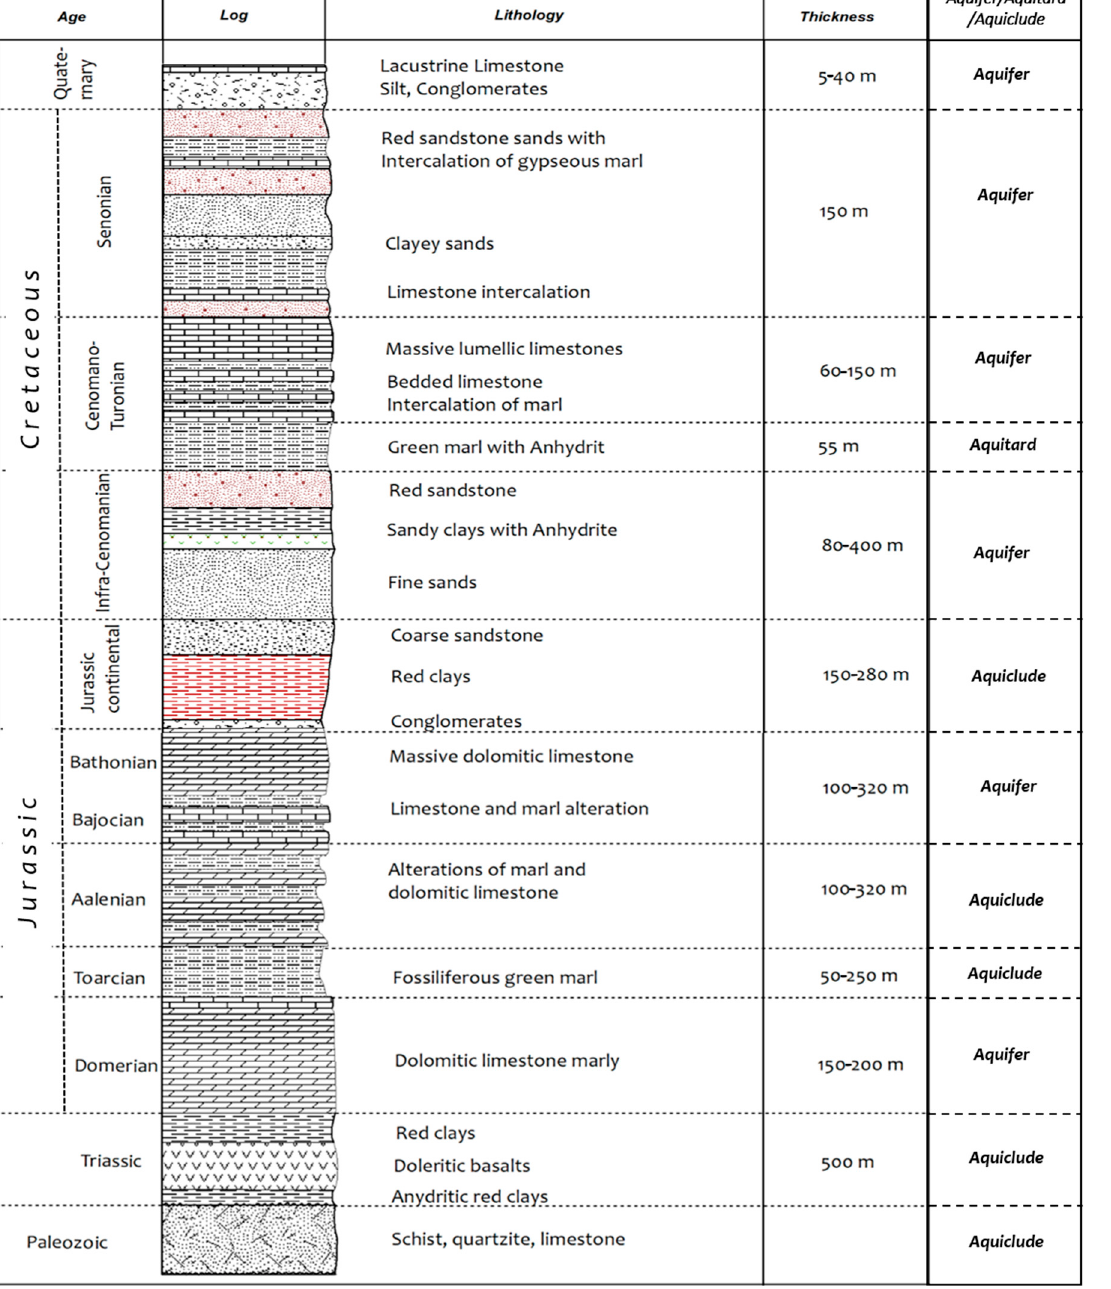
Figure 2. Simplified stratigraphic column of the study area compiling the lithology of the various formations and aquifer characteristics. Modified from [34] .